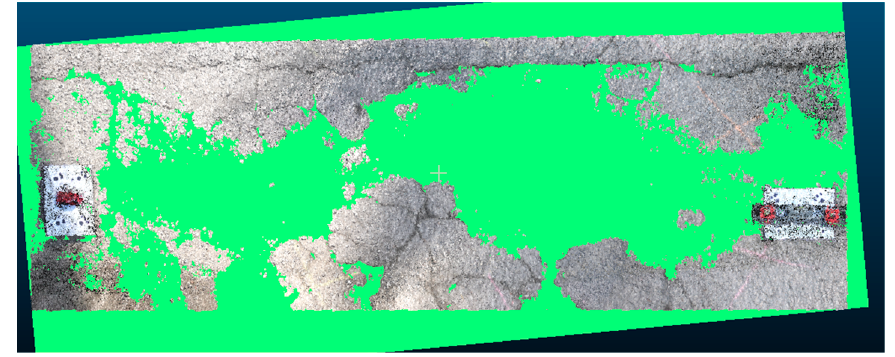
Figure 21. Application of plane shape through RANSAC algorithm.